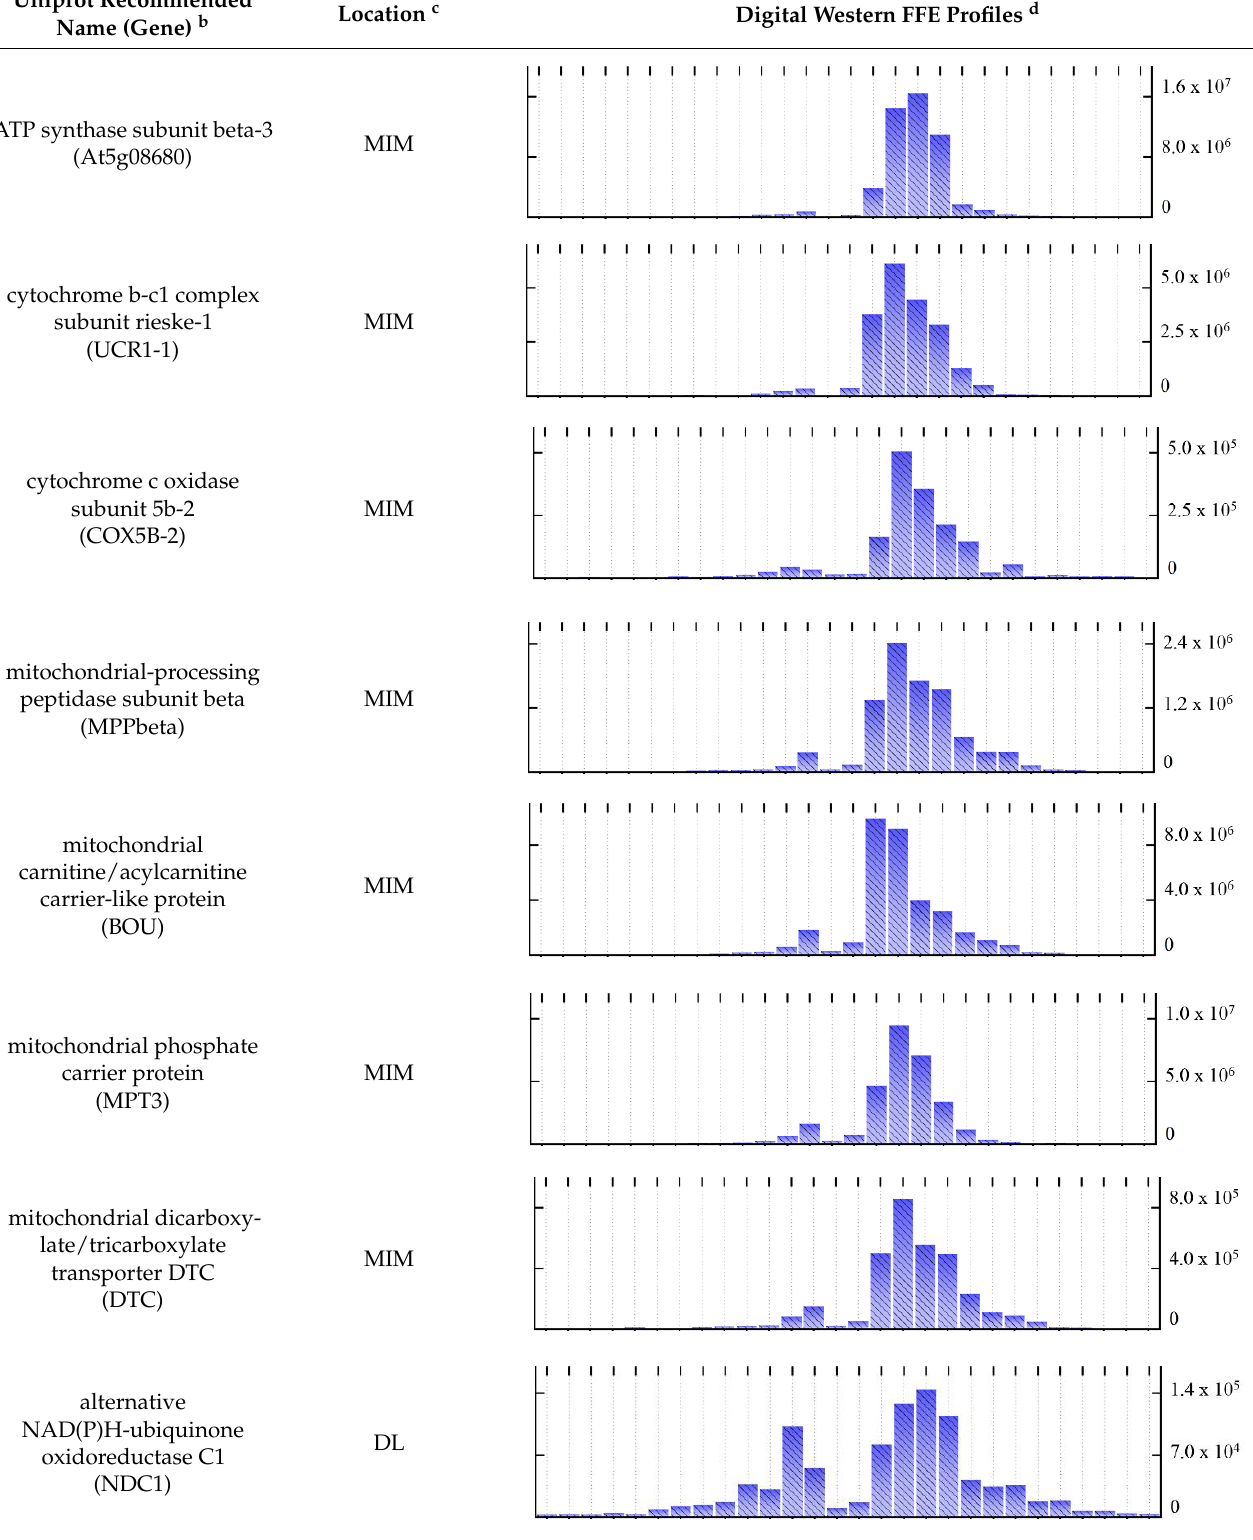
a,b,d Footnotes are the same as for Table 1; c Subcellular location abbreviations: MIM/MOM, mitochondrial inner/outer membrane; DL, protein dual-localized to chloroplast and mitochondrial membranes.